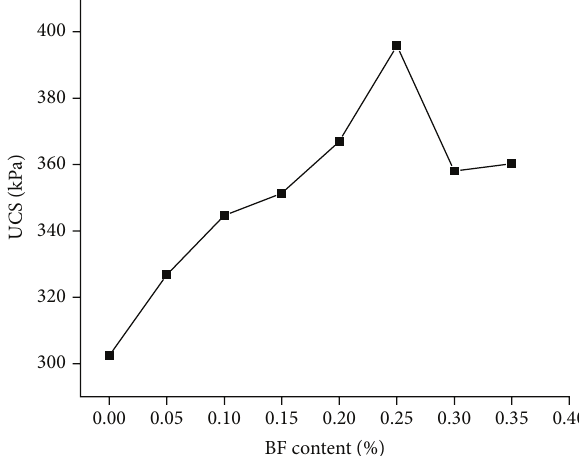
Table 4: Unconfined compressive strengths of soil samples.